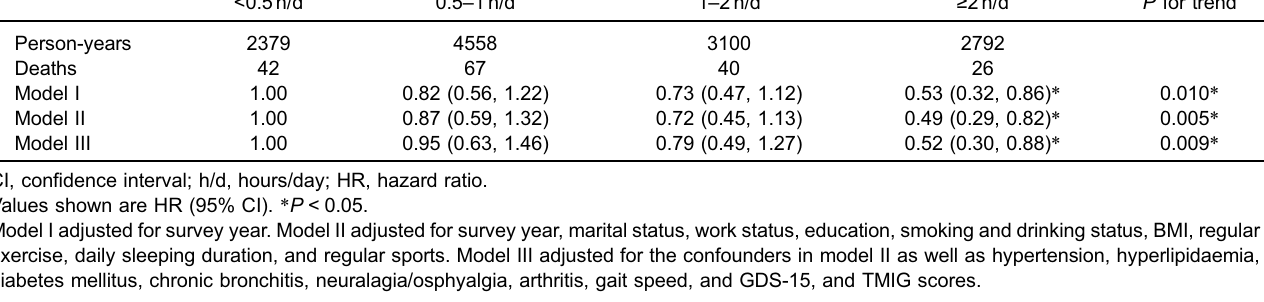
Table 2. Association of daily walking with mortality in all participants <0.5h/d